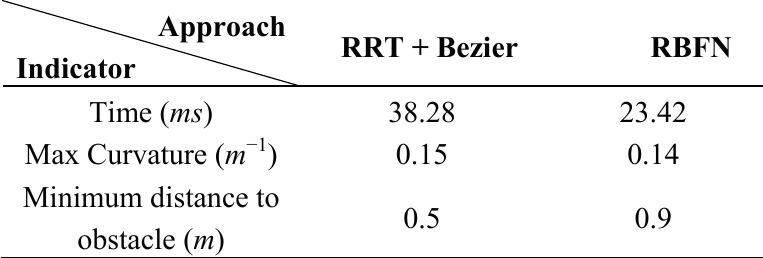
Table 2. The comparison of final path with two